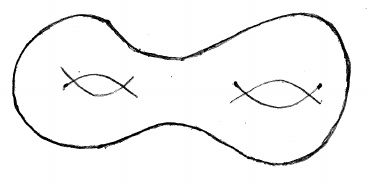
S reg is 2-sphere with two (cid:101)